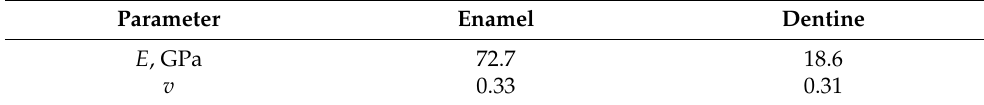
Table 1. Physical-mechanical properties of dental tissues. Parameter Enamel